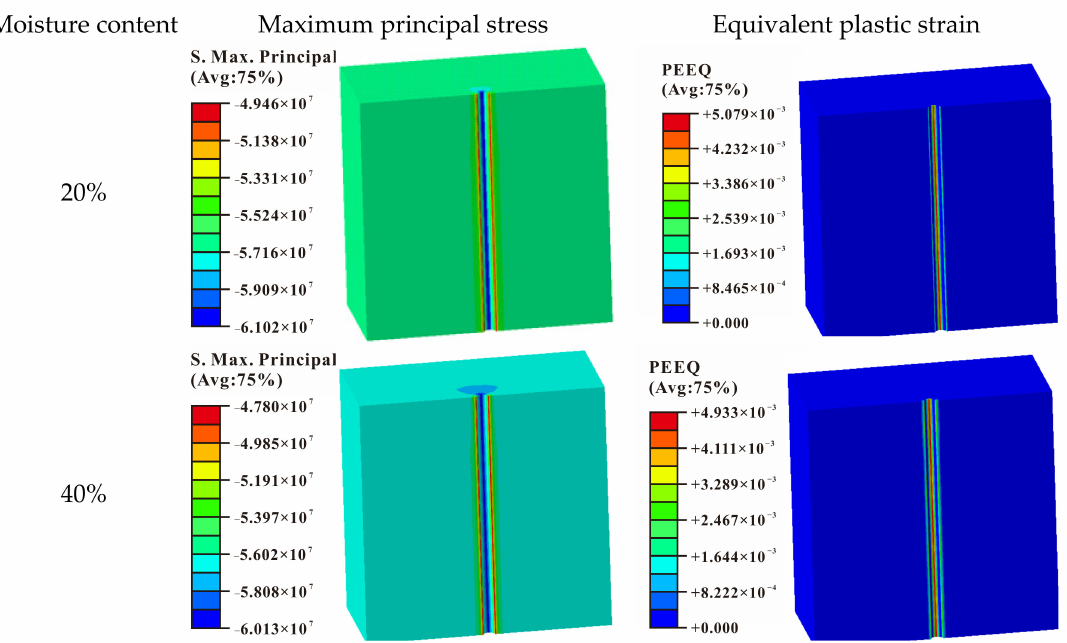
Figure 10. Maximum principal stress and the equivalent plastic strain distribution of the wells at the CSL.